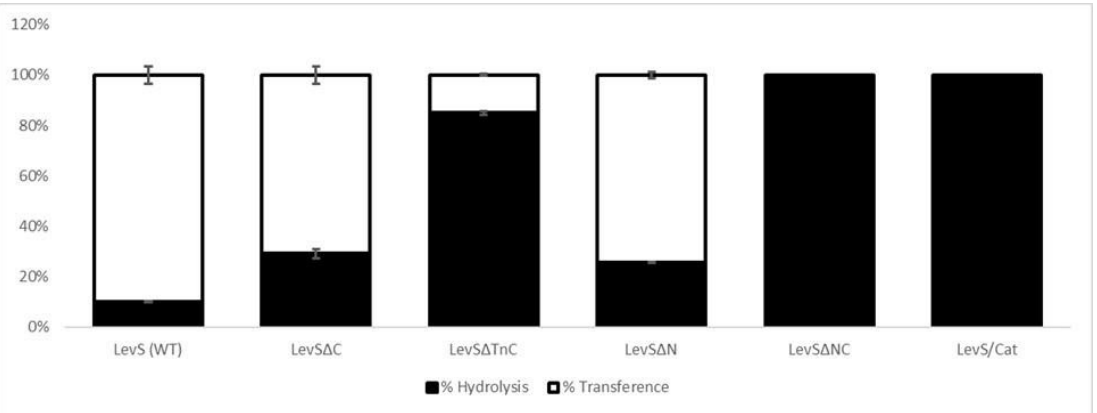
Figure 3. Hydrolysis and transfructosylation specificity of LevS and truncated forms. Reactions were carried out at 30 °C in 50 mM acetate buffer (pH 6) containing 1 mM CaCl2 and 290 mM sucrose as substrate.